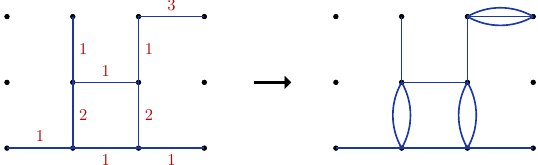
Figure 5: A current m with ∂ m = { 1,2,3,4 } (left) and the corresponding graph (cid:77) (right).